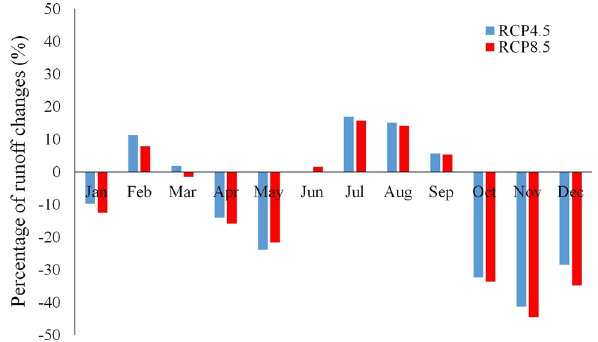
Fig. 8 Percentage of monthly runoff changes in the future period under two scenarios (RCP4.5 and RCP8.5)